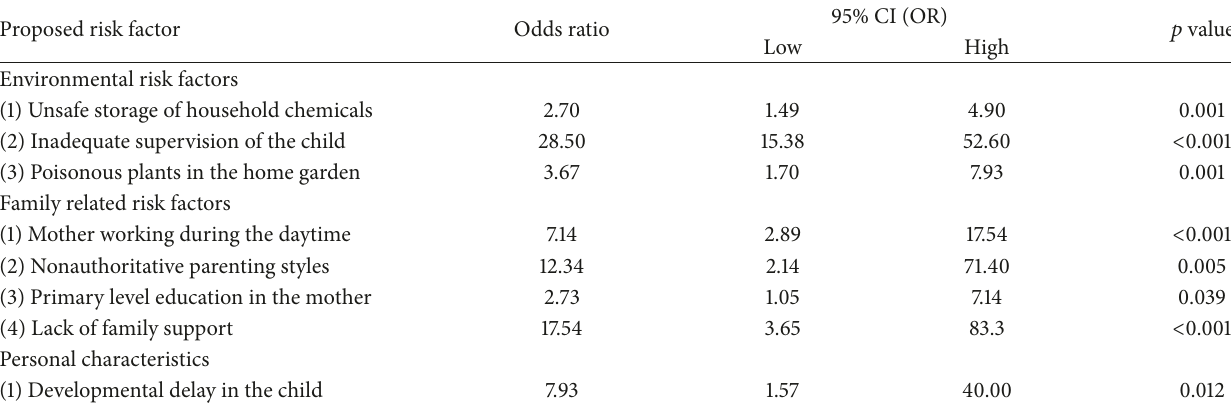
Table 5: Multivariate analysis of independent risk factors for acute unintentional pediatric poisoning in the binary logistic regression model. Proposed risk